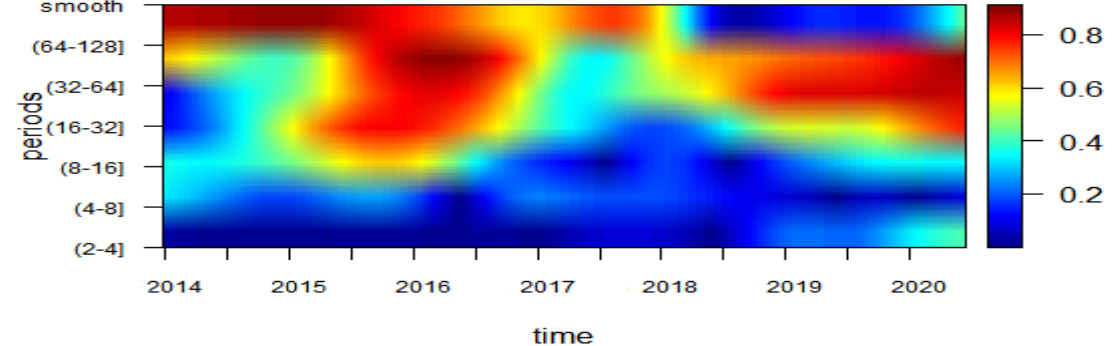
Figure 3. Wavelet multiple correlations between the S&P 500 and HIS stock market returns.